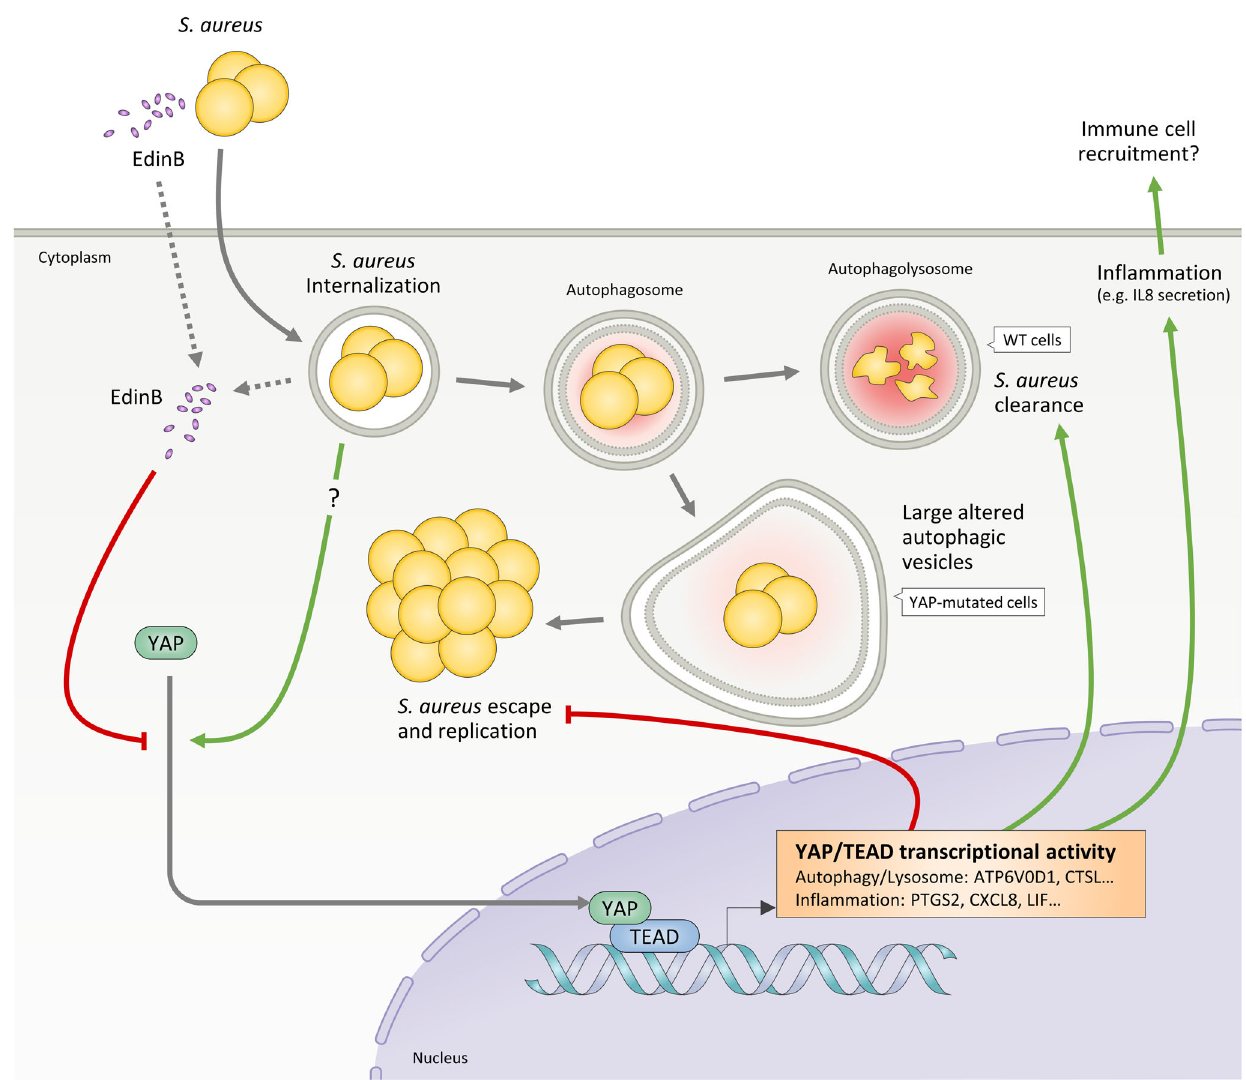
Fig. 8| ModeloftheYAP-mediatedcell-autonomousimmuneresponseagainst intracellular S. aureus . After S. aureus internalization by the host cell, YAP is translocatedto thenucleusandpromotestheexpressionofhostgenesinvolvedin cell-autonomous immune response, including genes involved in autophagy, lyso- some activity and in fl ammatory response. In WT cells, autophagic machinery limit intracellular replication of S. aureus . In contrast, YAP-mutated cells, which have